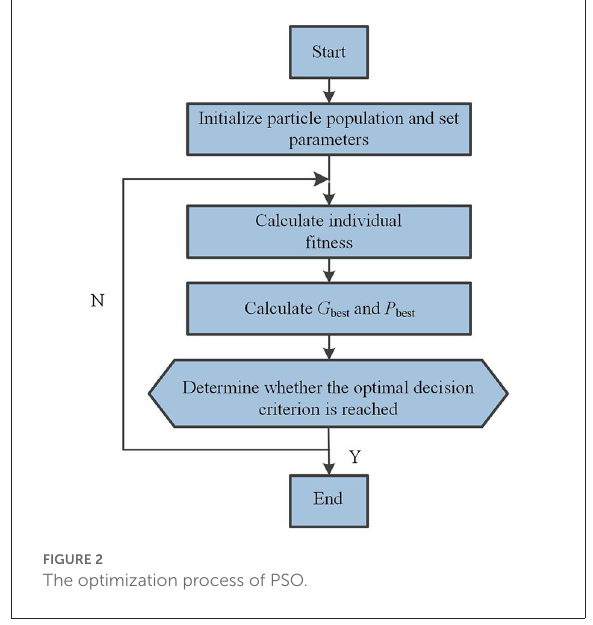
TABLE 1 Algorithm I: Conventional